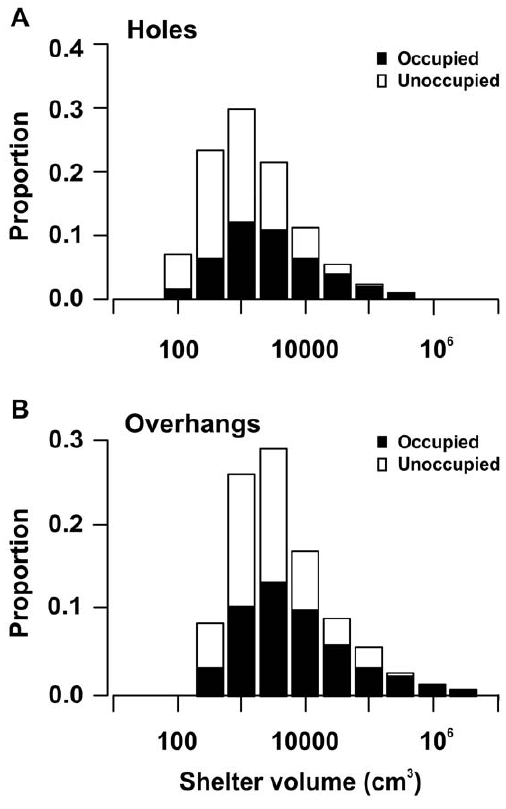
Figure 2. Frequency of holes and overhangs in relation to shelter volume. The proportional distribution of (A) holes (n=2,134) and (B) overhangs (n=729) in relation to shelter volume. Occupied shelters are shown as black bars and unoccupied shelters as white bars. Each bin has a width of 0.5 log 10 cm 3 . Bins with values smaller than 100 cm 3 are not shown because proportions were less than 0.001.